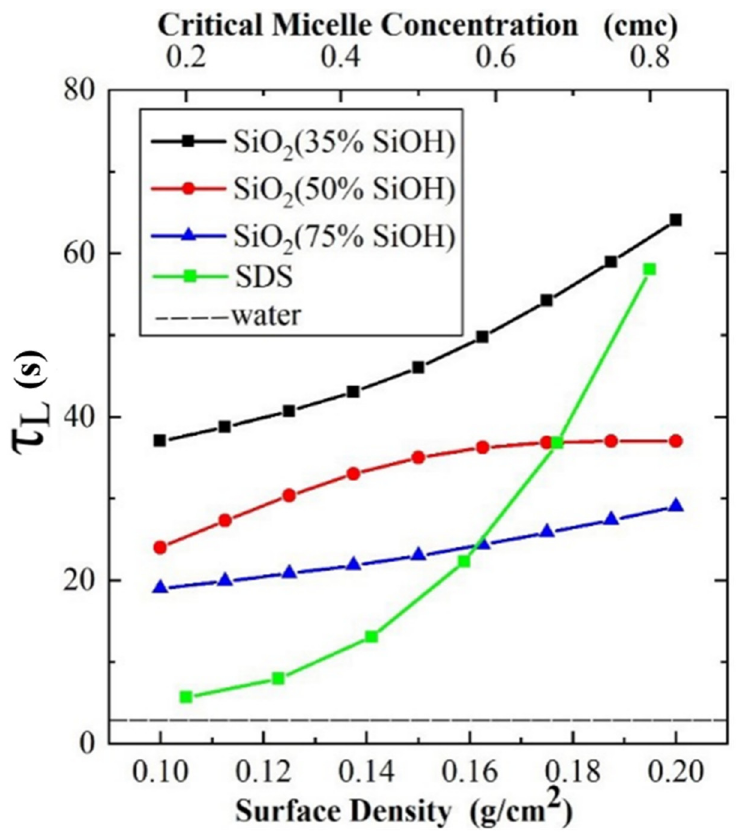
Figure 7. Lifetime of bubbles.